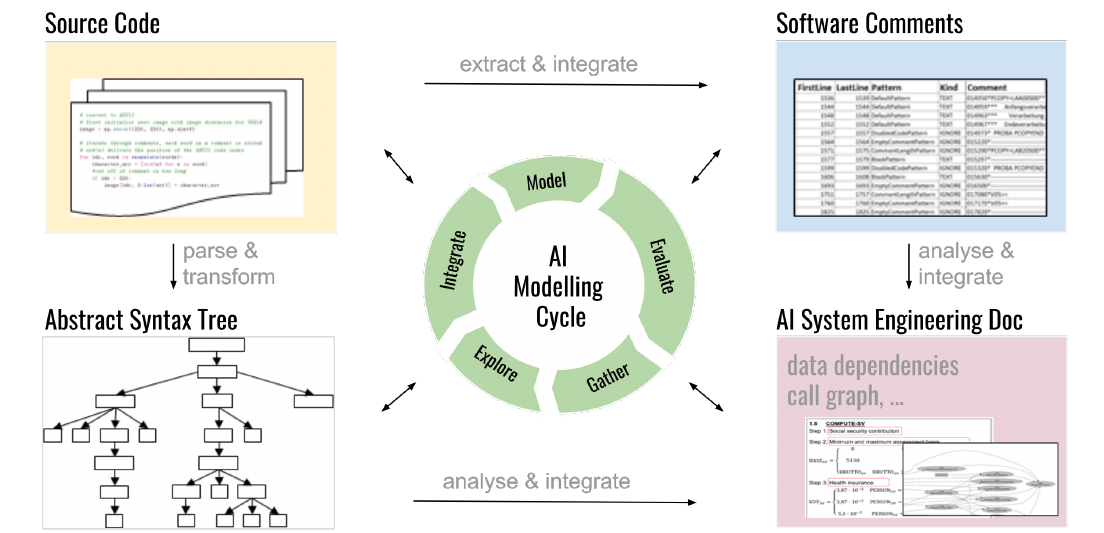
Figure 7. Automated software documentation for AI system engineering